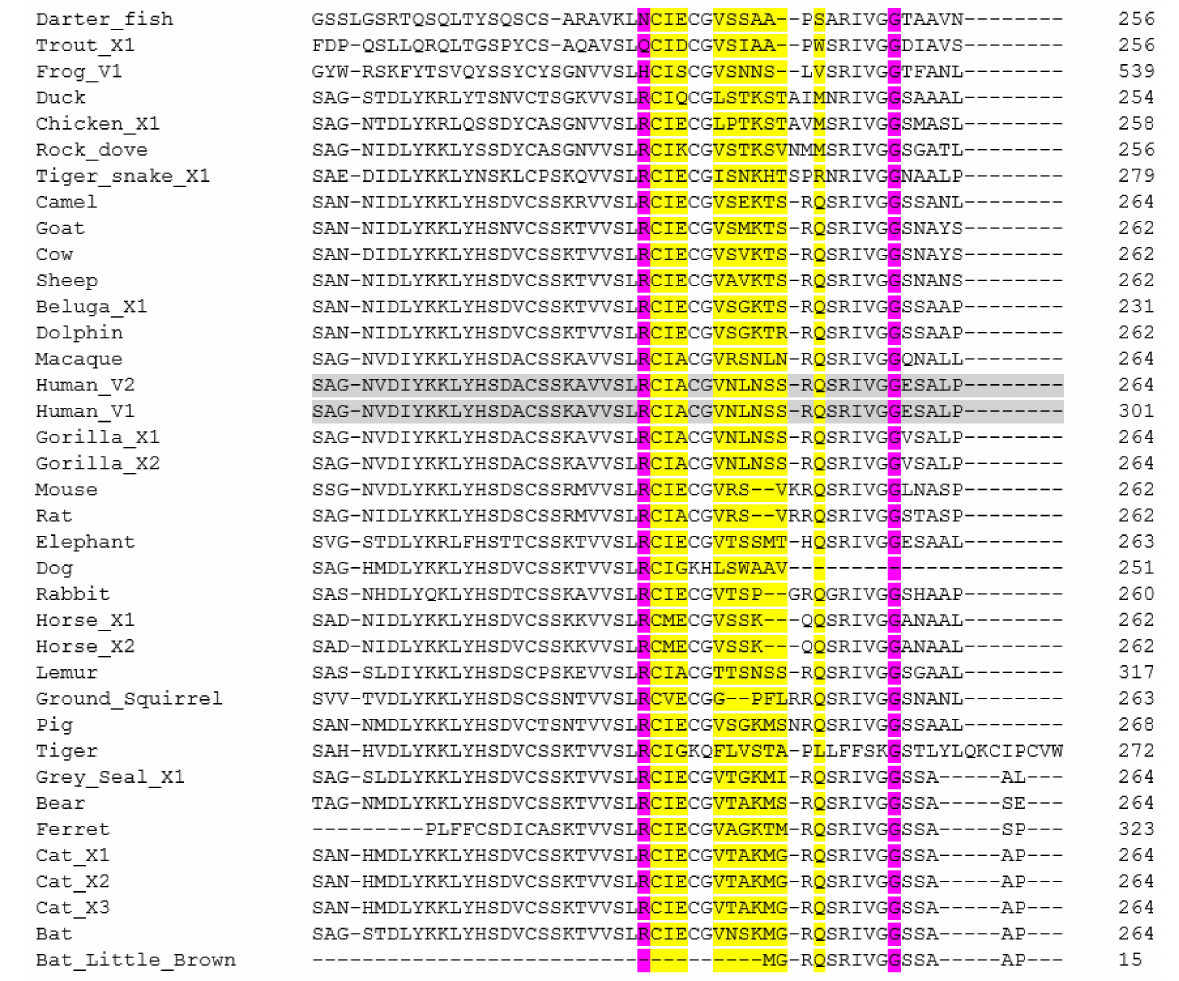
Figure 3. Amino acid sequence alignment of TMPRSS2 polypeptides from a range of animal species: a short section is shown here, whilst the full sequence alignments are shown in Supplementary Figure S2. Accession Numbers of the polypeptide sequences used are given in Table 1. Alignments were carried out using Clustal Omega [45]. Human sequence is highlighted in grey to aid comparison to other sequences. Polymorphisms reported by Hou et al. [20] are in purple. Amino acids involved in the TMPRSS2/SARS-CoV-2 interactions are highlighted in yellow [49].